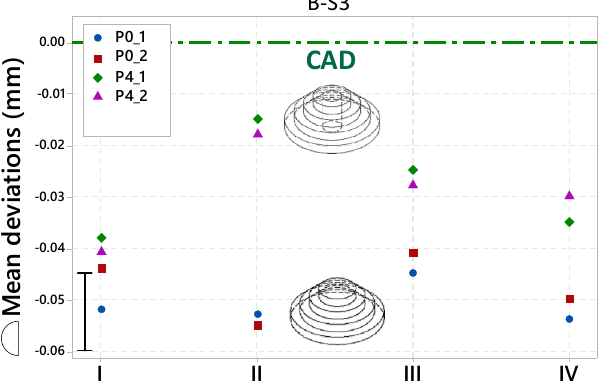
Figure 14. Three-dimensional (3D) profile mean deviations of the Shape B artifact having the biggest size (S3); P0–P4 designate the absence or the presence of a pocket .